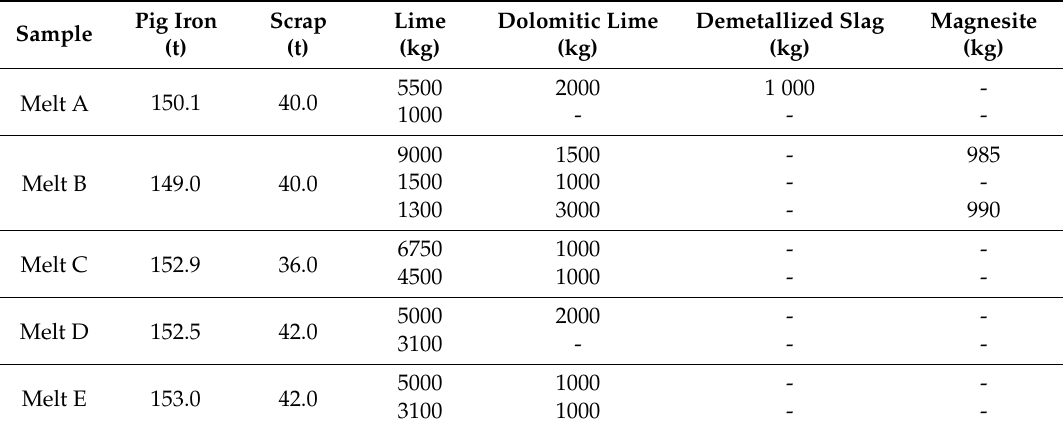
Table 1. Quantities of the charged raw materials and doses of the slag-forming additives.